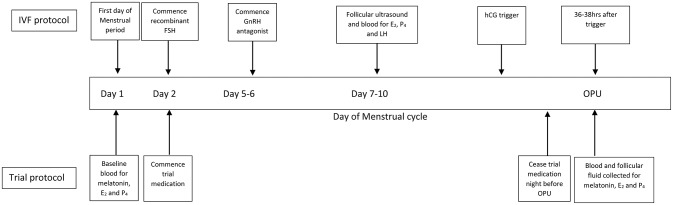
IVF and general trial protocol. IVF, in-vitro fertilization; FSH, follicle stimulating hormone; GnRH, gonadotrophin releasing hormone; hCG, human chorionic gonadotrophin; E2, estradiol; P4, progesterone; OPU, oocyte retrieval.